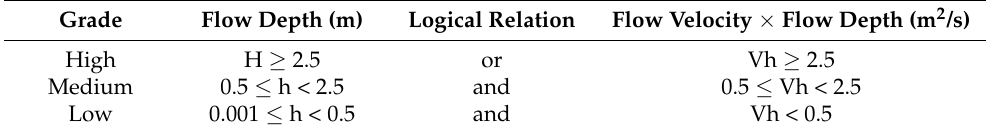
Table 5. Impact grade of the debris flow.